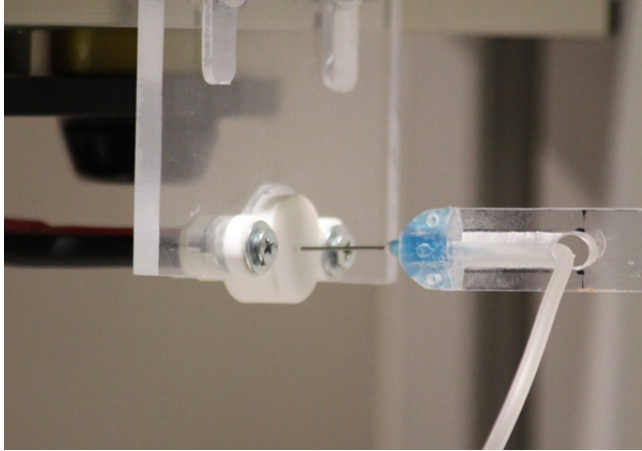
Figure 4. PSJ actuator with the Pitot